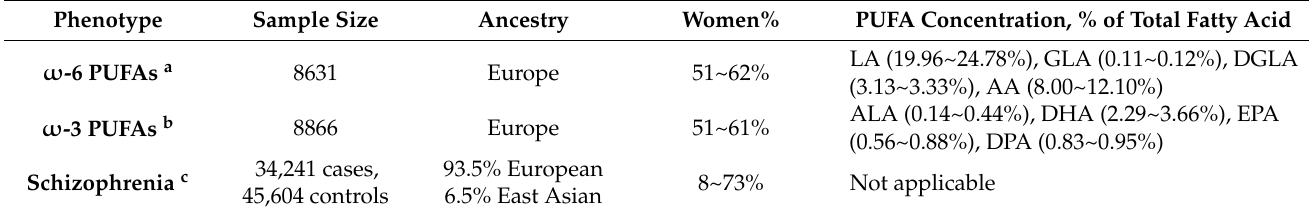
Table 1. Information of data on PUFAs and schizophrenia of MR